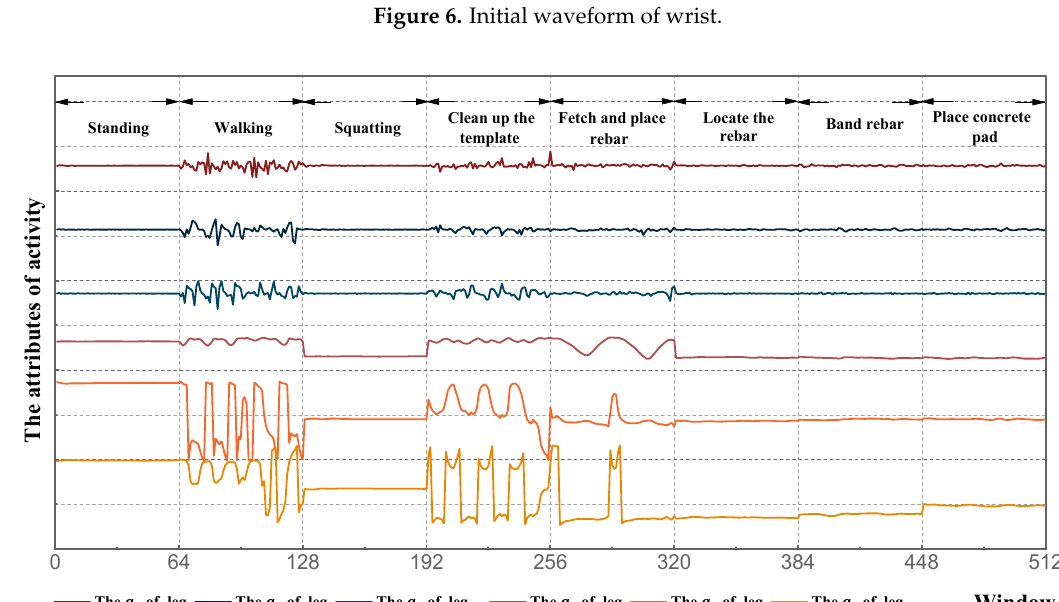
Figure 7. Initial waveform of leg.